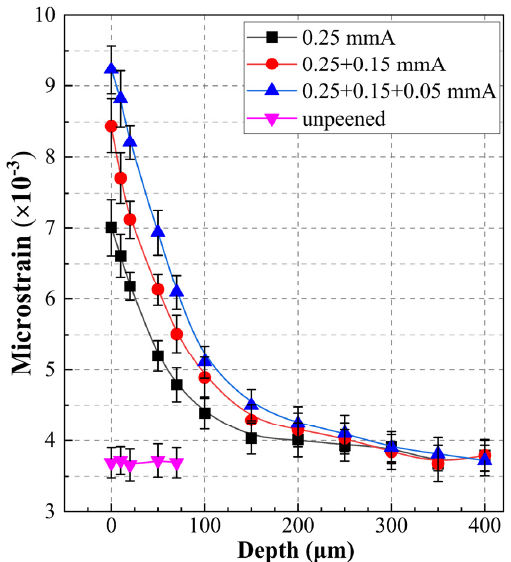
Figure 6. Distribution of microstrain of CNTs/Al − Mg − Si alloy composite after multiple shot peen- ing.